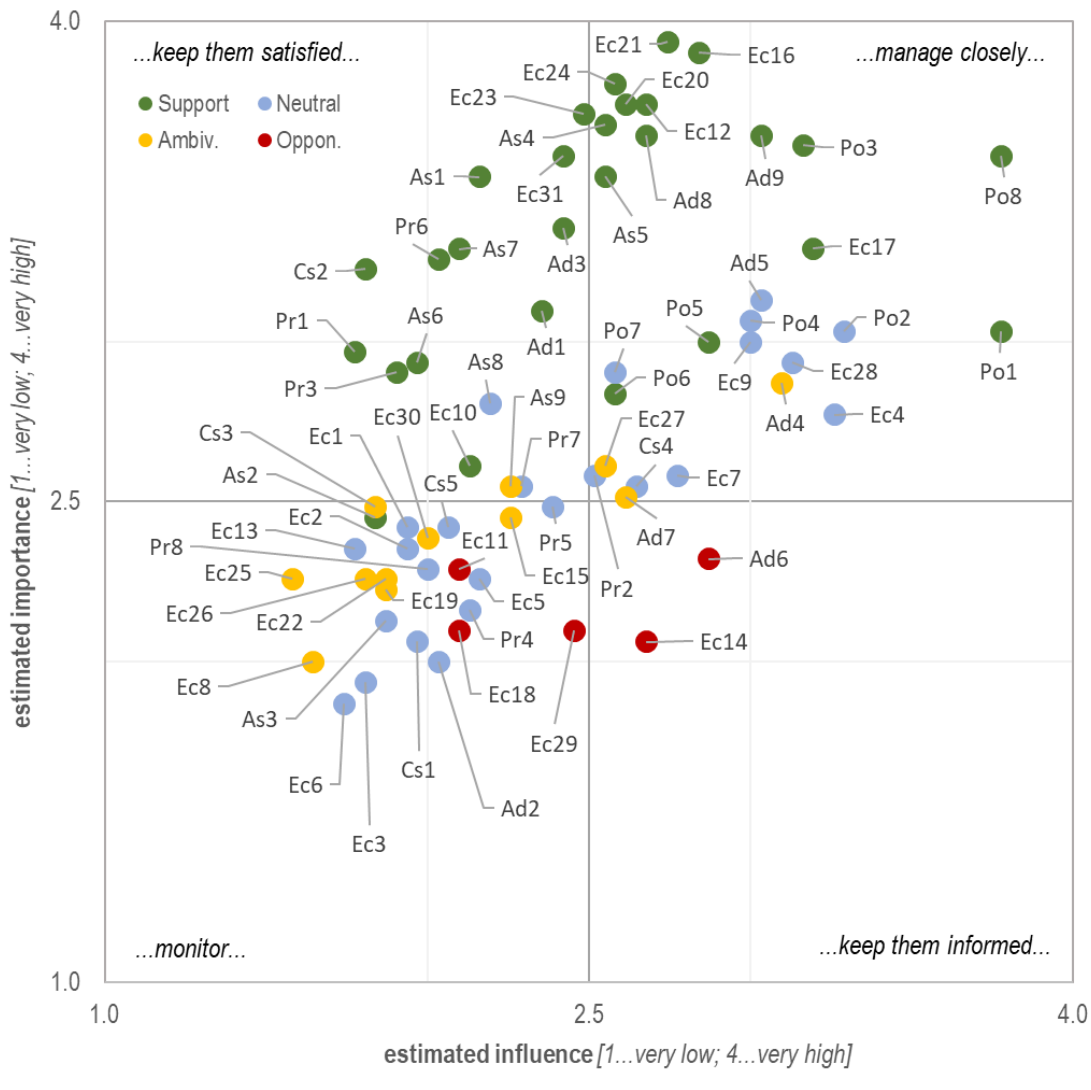
Figure 4. Influence and importance of stakeholders towards zero-emission heavy-duty trucks.